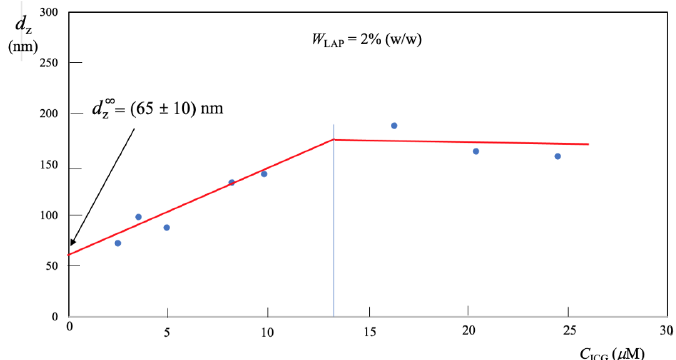
Figure 3. Hydrodynamic LAP diameter in ternary LAP-IGG-water system with fixed mass fraction of LAP W LAP = 0.02. (the curve is a guide for the